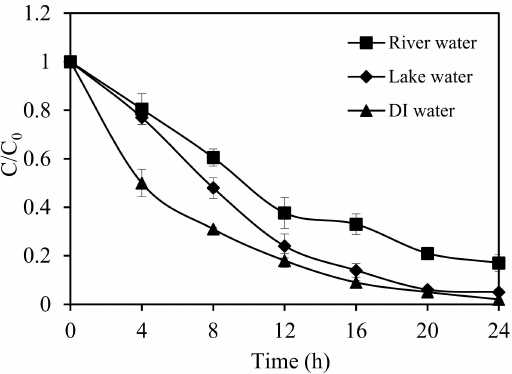
Figure 12. Photocatalytic degradation rates of ethiofencarb in deionized and real water samples. Experimental conditions: SnIn 4 S 8 concentration, 0.5 g L − 1 ; pH 3.